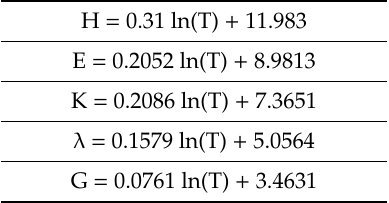
Table 6. Dynamic elastic moduli as a function of exposure